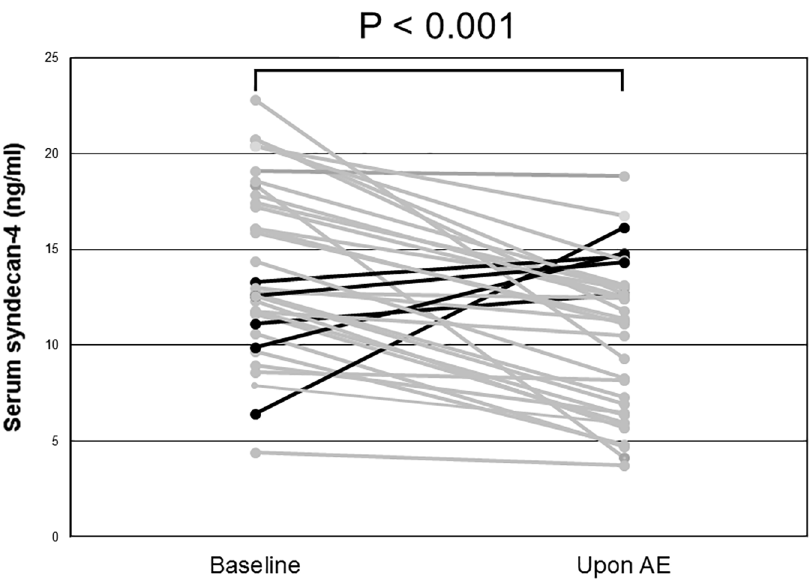
Fig 2. Changes in serum syndecan-4 levels of IIP patients before and upon AE. Serum syndecan-4 levels were comparedin the same patients for whom analysiswas possibleduringstability and upon acute exacerbation (n = 34). Serum syndecan-4levels were significantly lower duringAE than in the stable phase. AE: acute exacerbation. Wilcoxon’ssigned-rank test was used for statistical